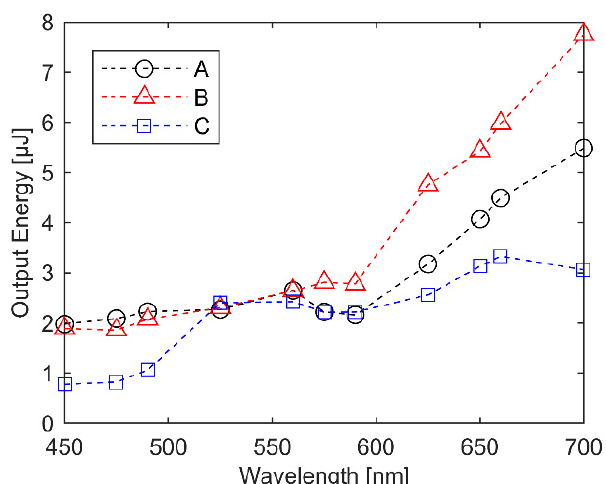
Figure 3. Optical power limiting (OPL) spectra of molecules “A” (black circles), “B” (red triangles), and “C” (blue squares). The output energy was calculated by doing a linear fit of every point above 20 J/cm 2 input fluence and taking the resulting value at 25 J/cm 2 input fluence.